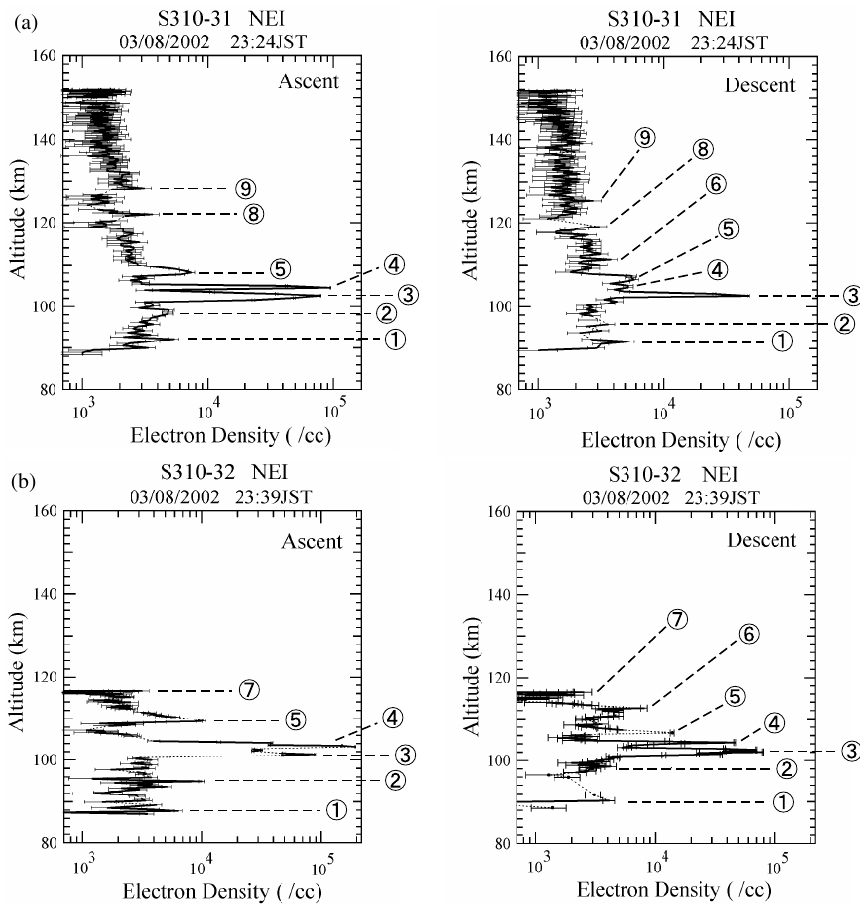
Fig. 4. (a) Altitude profiles of electron number density obtained by NEI on board the S310-31 rocket. Error bars show the accuracy of measurement and data interpretation using NEI. There are sharp peaks due to sporadic- E layer at the altitude of about 102–105km. There is only one sharp peak in the descending phase, although there are two sharp peaks in the ascending phase. The peaks in the near altitudes are numbered as the same peaks for the following analysis. (b) Altitude profiles of electron number density obtained by NEI on board the S310-32 rocket. Dashed lines indicate the data blank due to the TMA